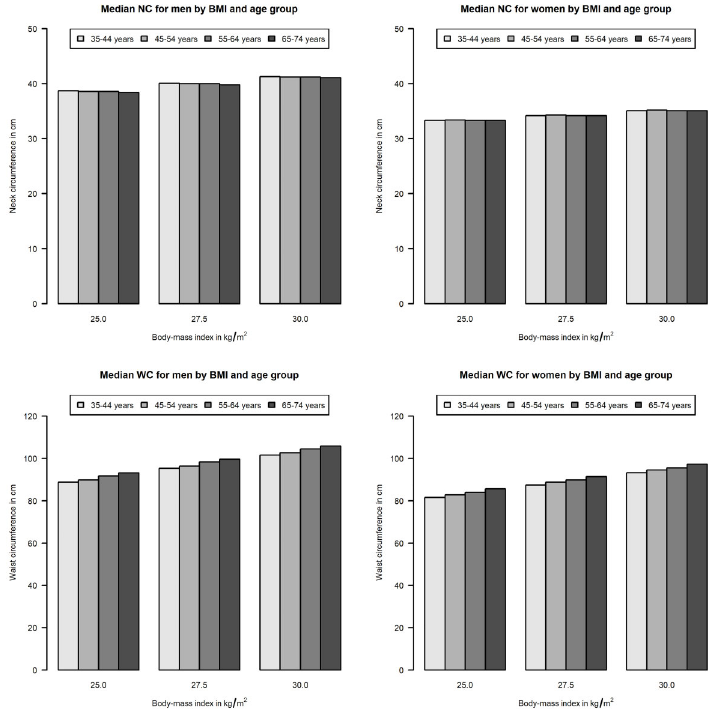
Figure 3. Median waist (WC) and neck circumference (NC) values according to age strata, for men and women with body mass index of 25.0, 27.5, and 30.0 kg/m 2 . Data are reported as